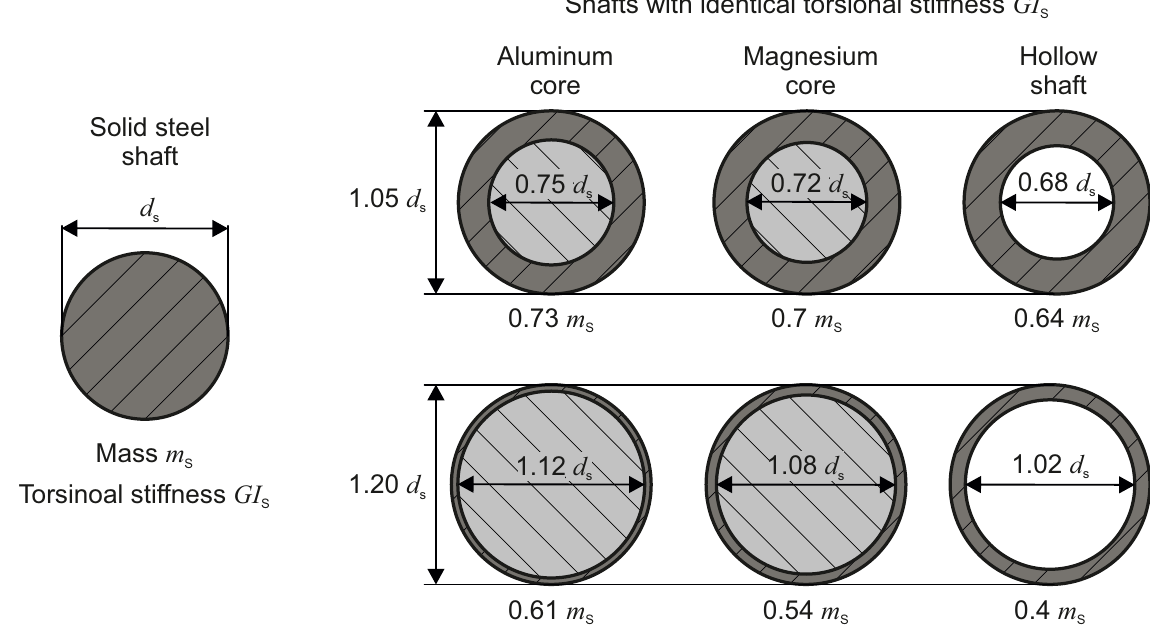
Figure 18. Mass savings for substituting a solid steel shaft by composite shafts with aluminum core, magnesium core and hollow shafts with identical torsional stiffness.